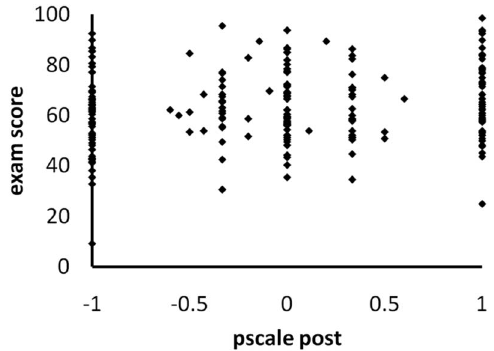
FIG. 4. The correlation between pscale at the end of the semes- ter and the exam score, where pscale= (cid:1)